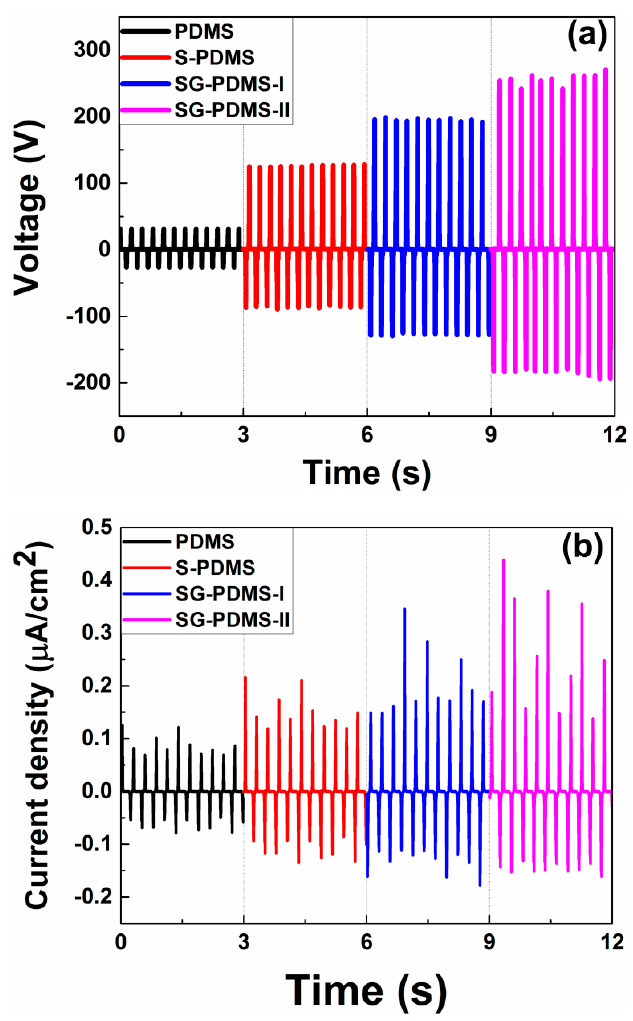
Figure 6. ( a ) Open-circuit output voltage and ( b ) short-circuit current density of TENG devices.